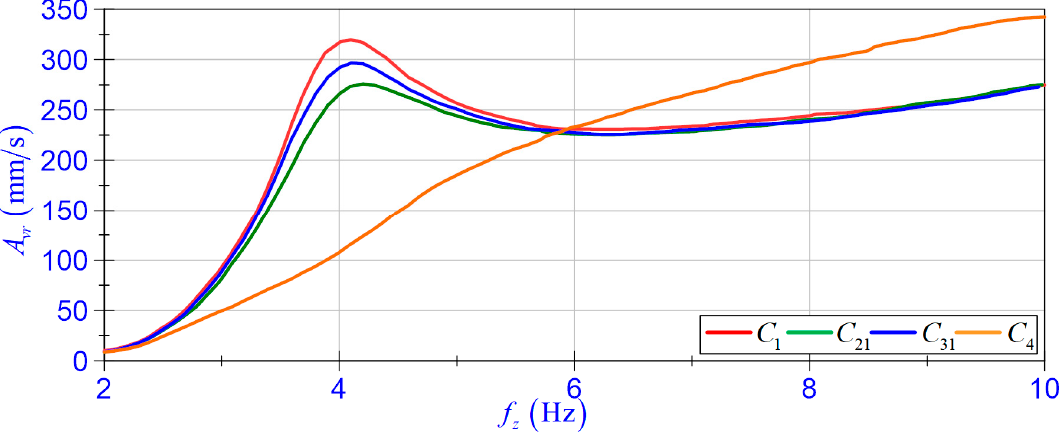
Figure 9. Relative velocity amplitude A vr vs. frequency f z .